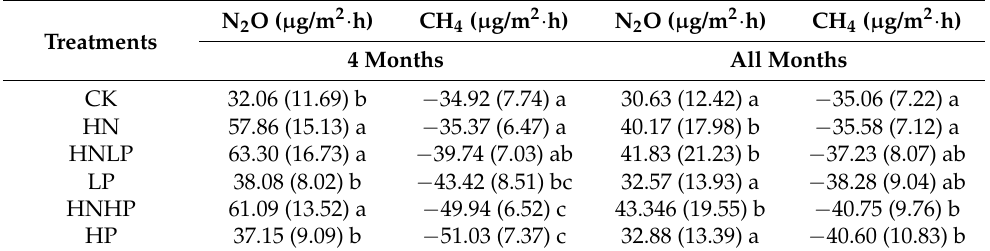
Table 2. Average N 2 O emissions and CH 4 uptakes in a subtropical Chinese fir plantation over the first 4 months and the entire study period. Different letters denote significant ( p < 0.05) differences between treatments.